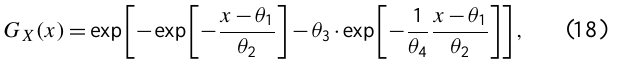
Fig. 2. Comparison of a GEV(dashed line) and a Gumbel (solid line) distribution function sharing the first two L -moments. The design event x T is plotted as a function of return period T (in loga- rithmic scale). The parameter values for the GEV are θ 1 = 0, θ 2 = 1, θ 3 = 0 . 15 in panel (A) and θ 1 = 0, θ 2 = 1, θ 3 = 0 . 45 in panel (B) . The parameters of the Gumbel distribution are found by matching the first two distribution L -moments to those of the GEV